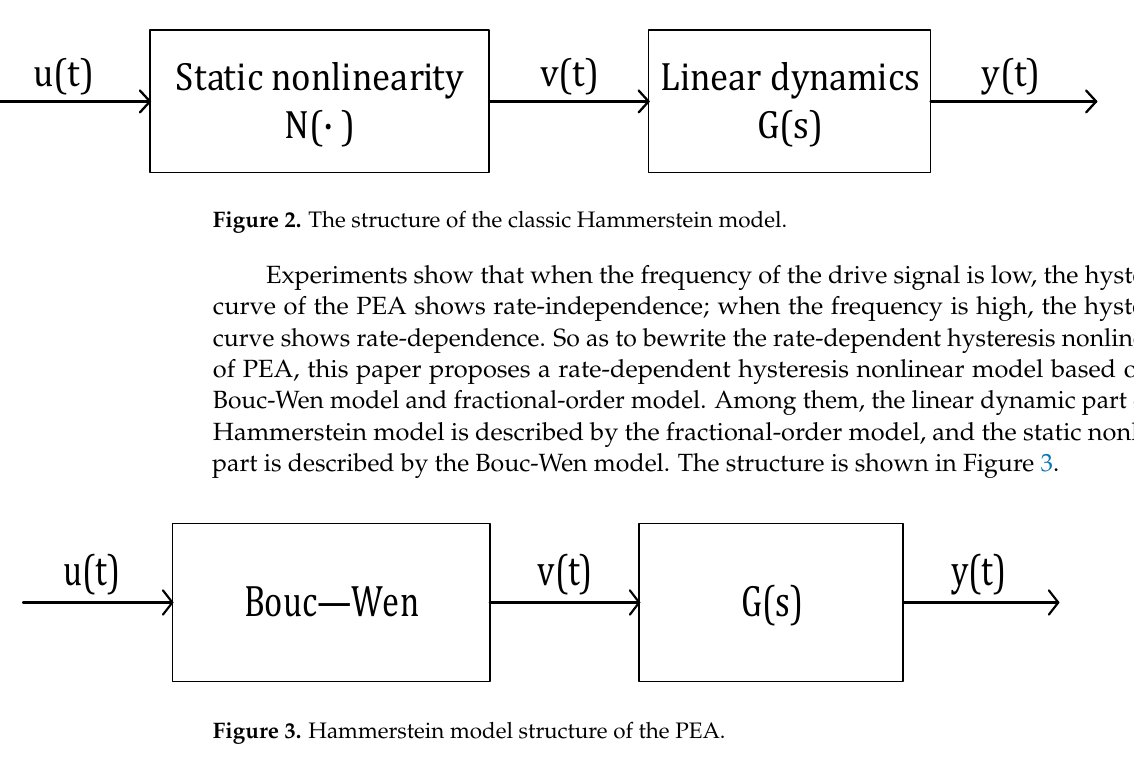
Figure 3. Hammerstein model structure of the PEA.